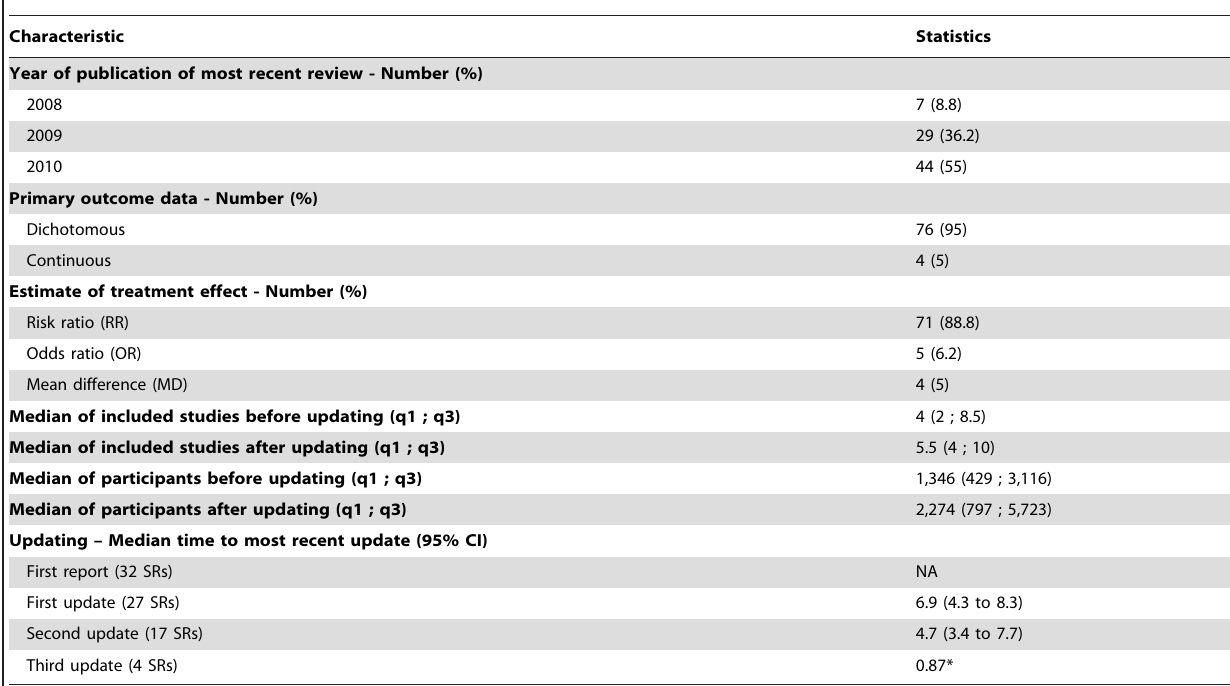
Table 2. Characteristics of CPCG reviews (N